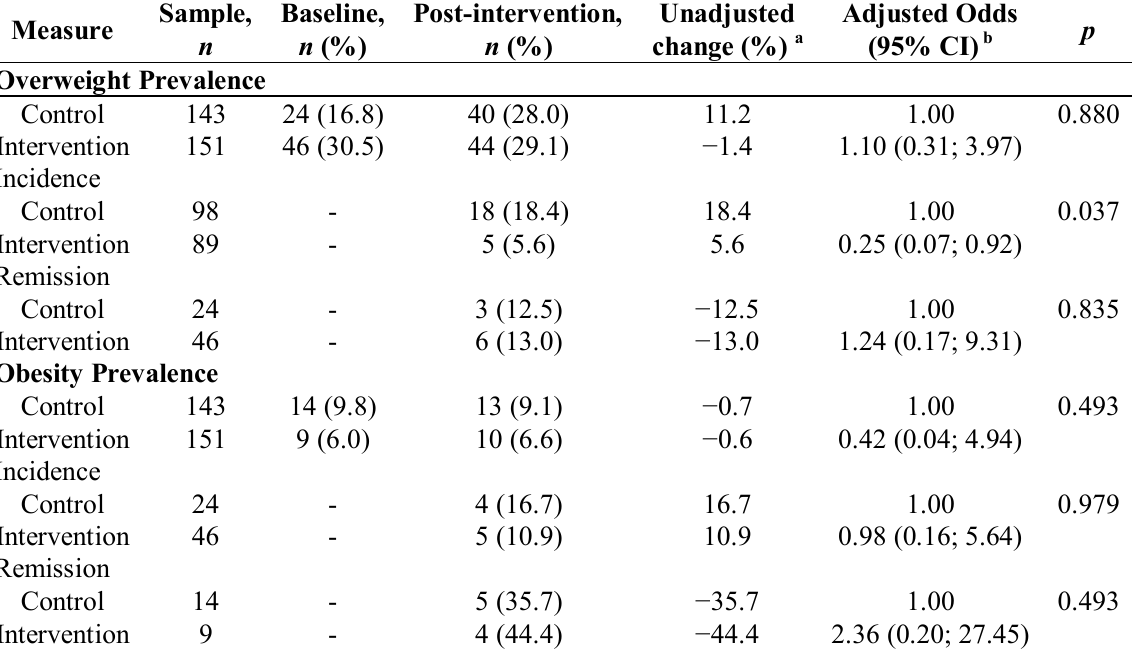
Table 3. Prevalence, incidence and remission of overweight and obesity after